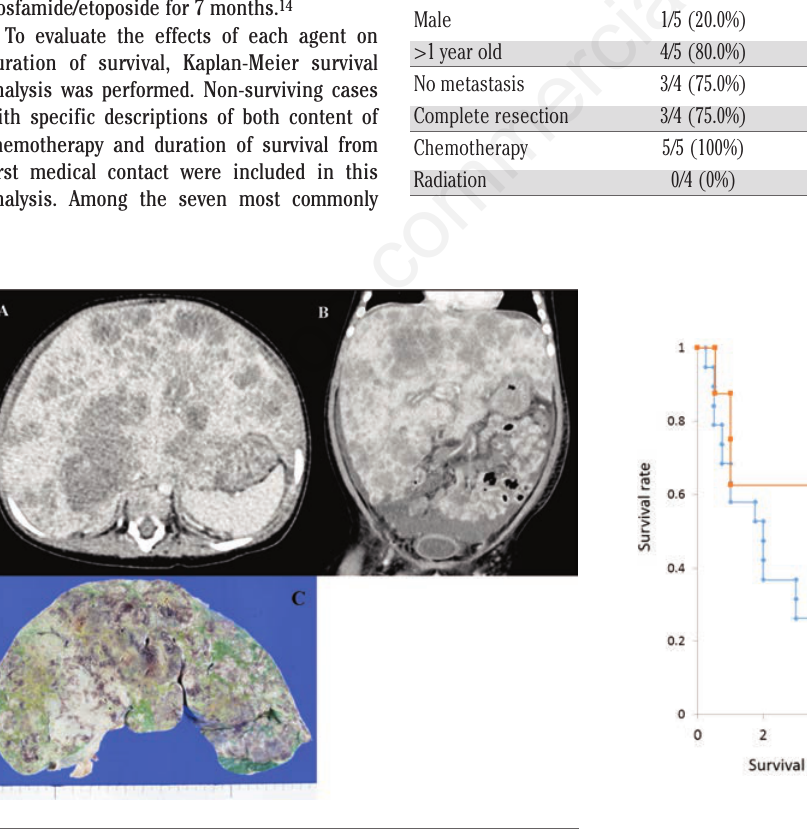
Figure 1. Axial (A) and coronal-view (B) computed tomography, and autopsy specimen (C) of the liver. Multiple tumors are seen throughout the enlarged liver.